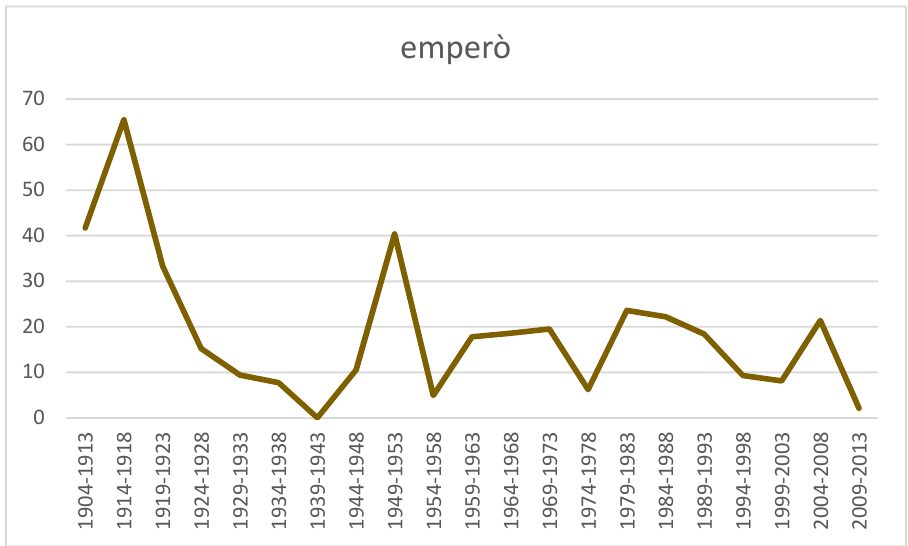
Figure 3. Relative frequency of emperò (normalized per 1 million words).